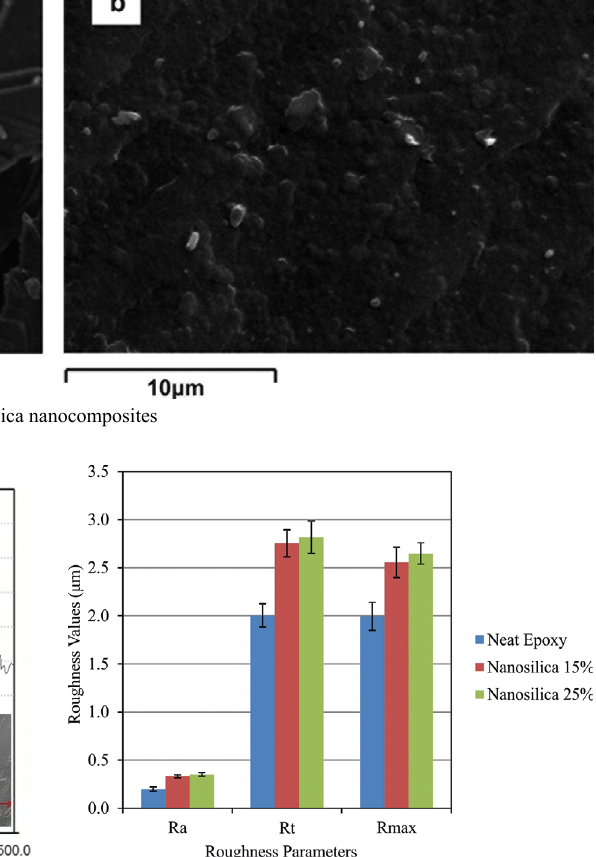
Figure 6. Surface texture parameters calculated from the profile traces as measured by the profilometer.